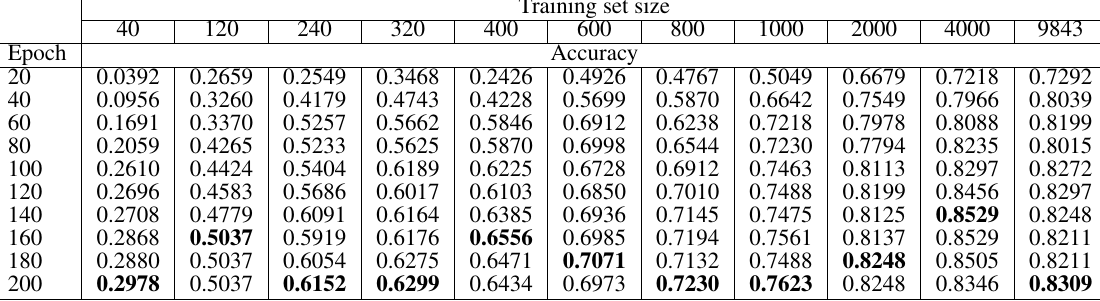
Table 3. Raw accuracy values every 10 epochs on training set size